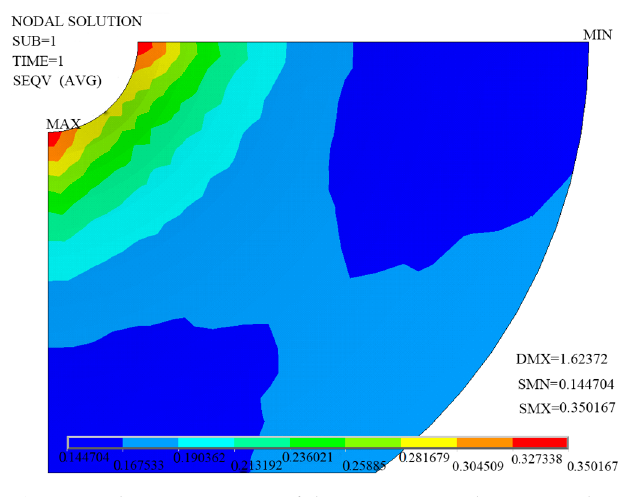
Figure 8. The contour map of the Mises equivalent stress distribution.